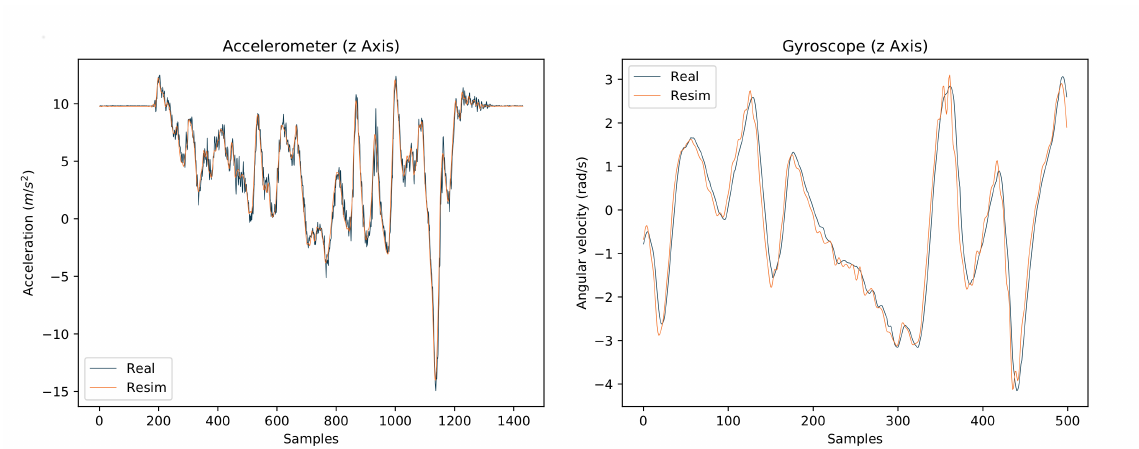
Figure 5. Comparison between real and re-simulated IMU data for one example from a capturing setup where IMUs were rigidly mounted on a rigid body and were additionally tracked with a marker based optical system. The frequency was 60 Hz, i.e., 60 samples correspond to one second.